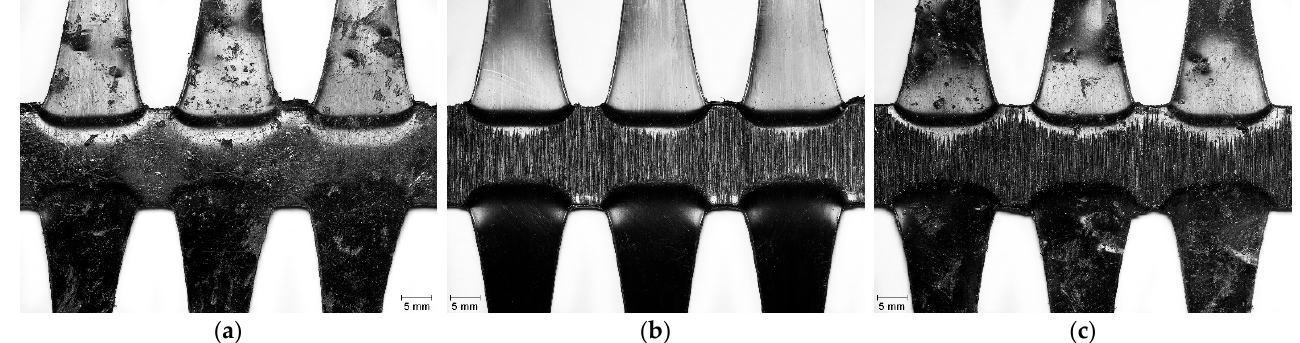
Figure 6. Visual inspection of EG after the degradation tests: ( a ) single exposure to MD tests; ( b ) single exposure to abrasion tests; ( c ) successive exposure to MD and abrasion tests.